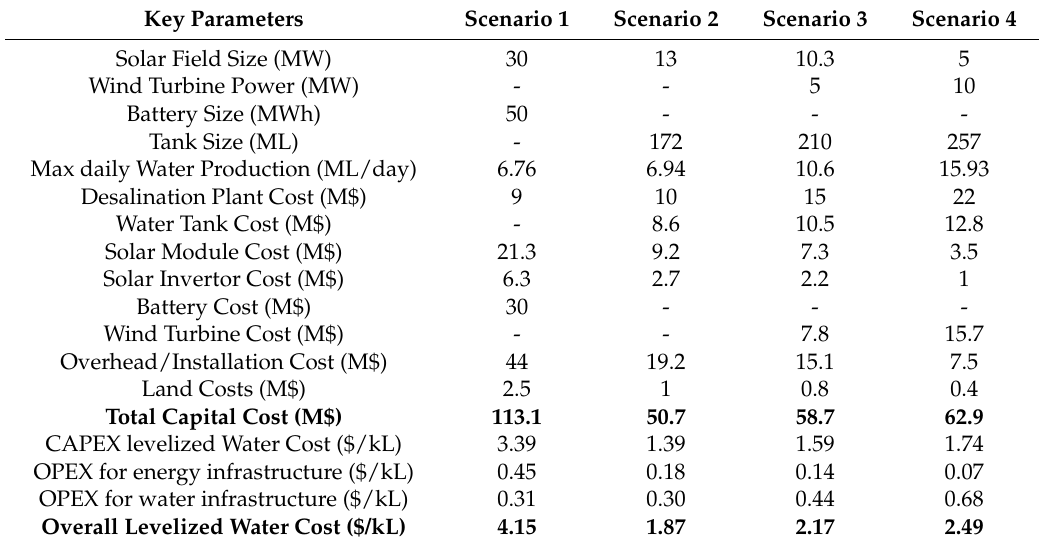
Table 5. Results comparison for all